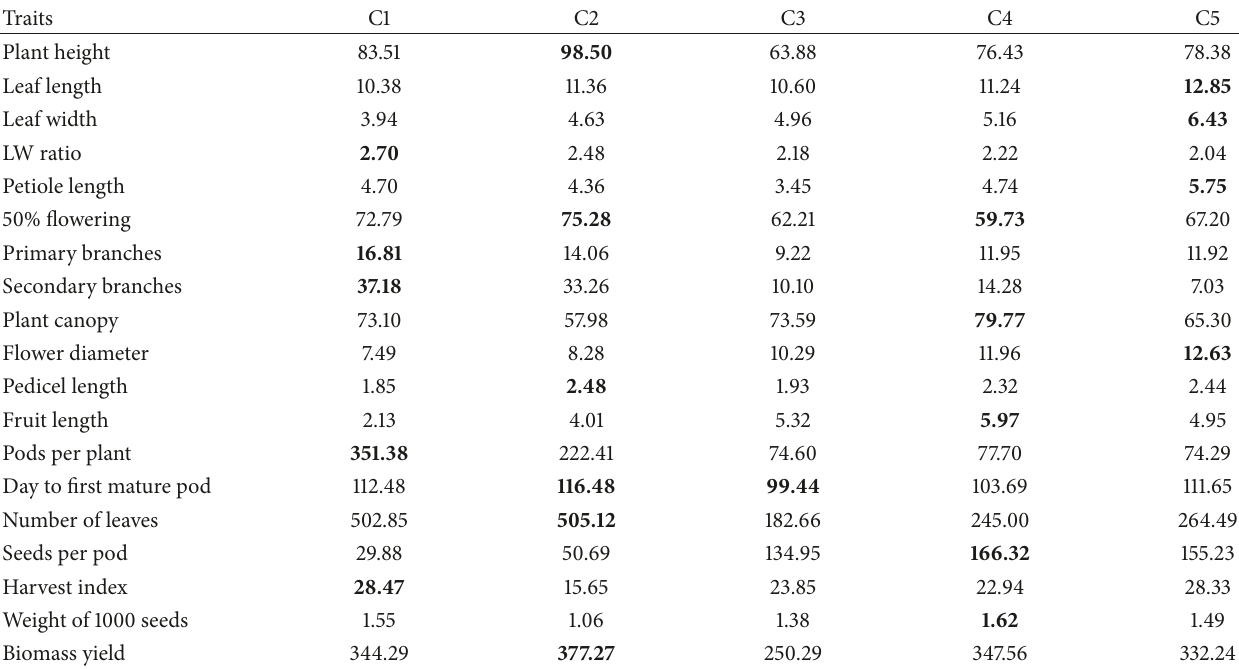
Table 7: Cluster analysis for 19 quantitative traits of Corchorus spp.